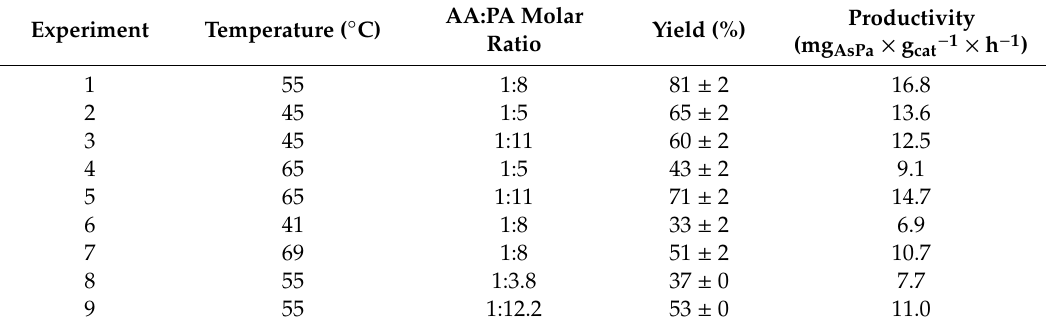
Table 3. Experimental design and results obtained in the reaction of synthesis of ascorbyl palmitate catalyzed by Novozym 435, using 2M2B as a solvent after 144 h of reaction, considering temperature and ascorbic acid to palmitic acid molar ratio (AA:AP) as